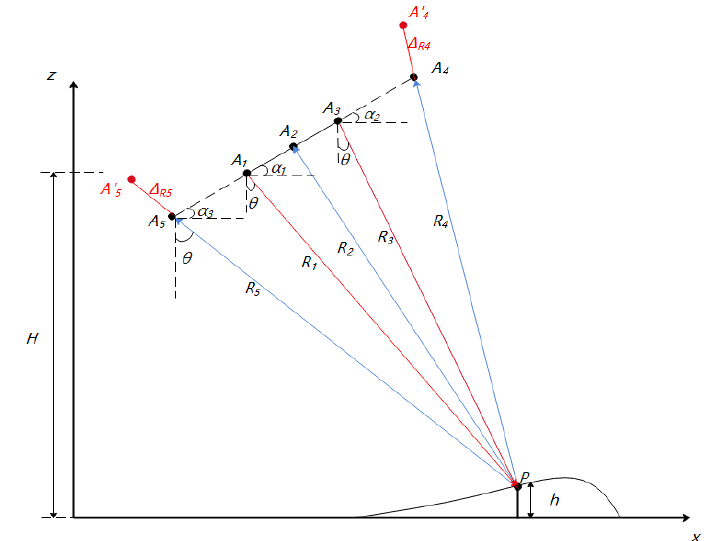
Figure 3. The schematic diagram of geometric measurement of the flexible